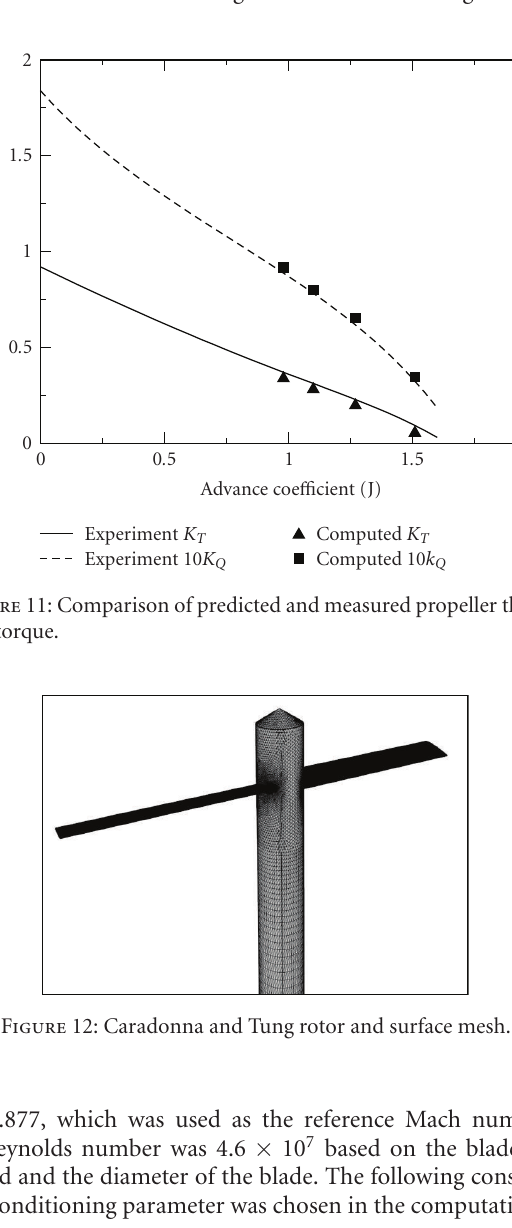
Figure 10: Convergence history of propeller thrust coe ffi cient at di ff erent advance ratios.